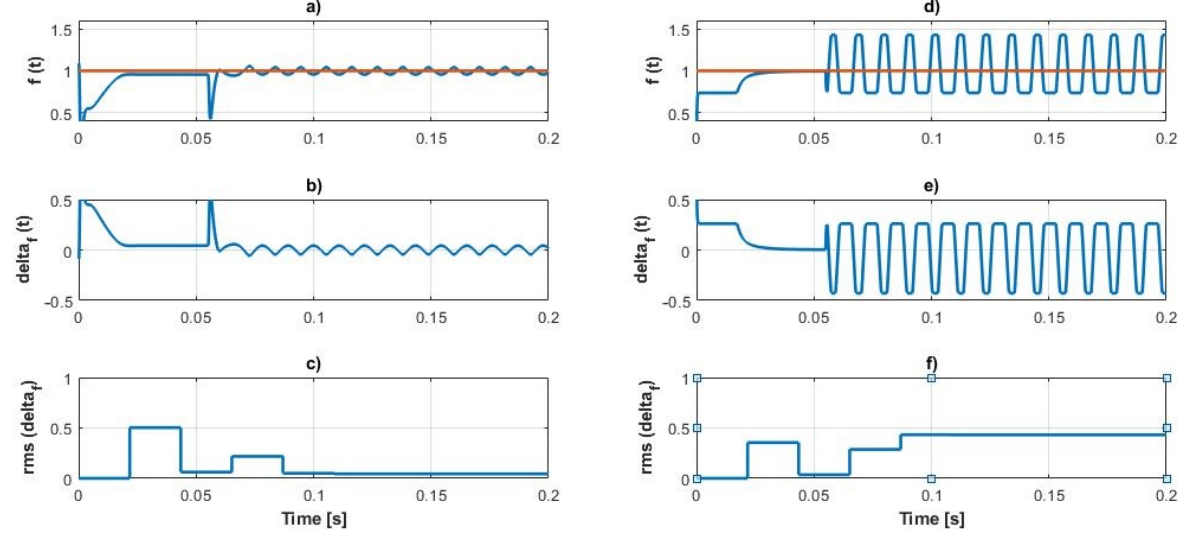
Figure 15. Frequency estimation during short circuit for RFE ( a – c ) and for SRF-FLL ( d – f ) where: ( a , d ) frequency estimated value (orange—reference, blue—tested algorithm), ( b , e ) frequency error between compared algorithms, and ( c , f ) RMS value-form frequency error.